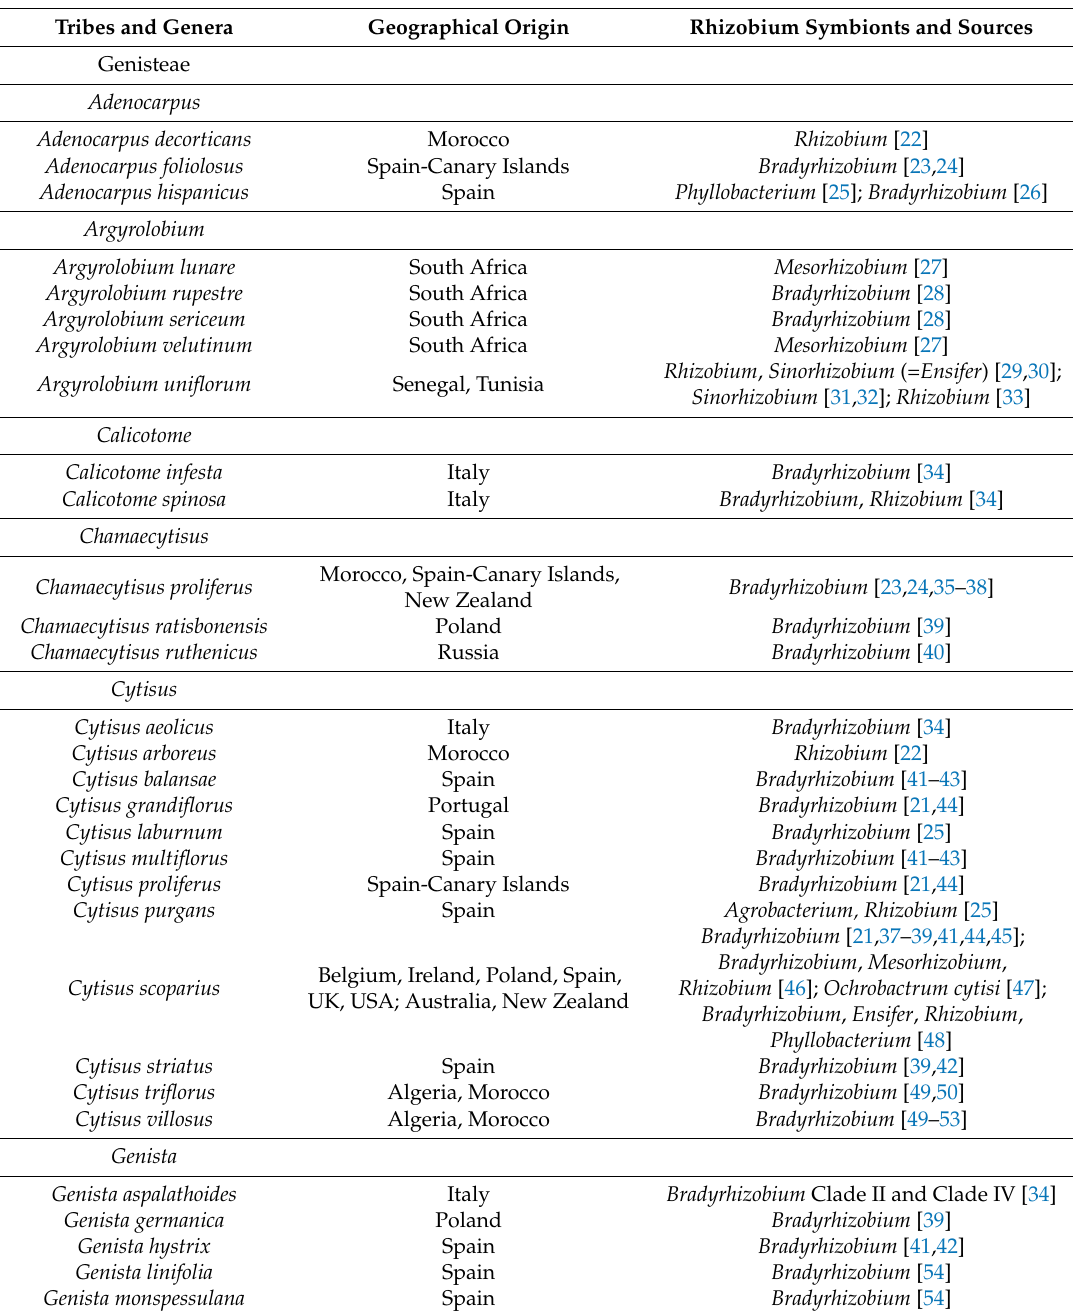
Table 1. Genisteae species and their rhizobium